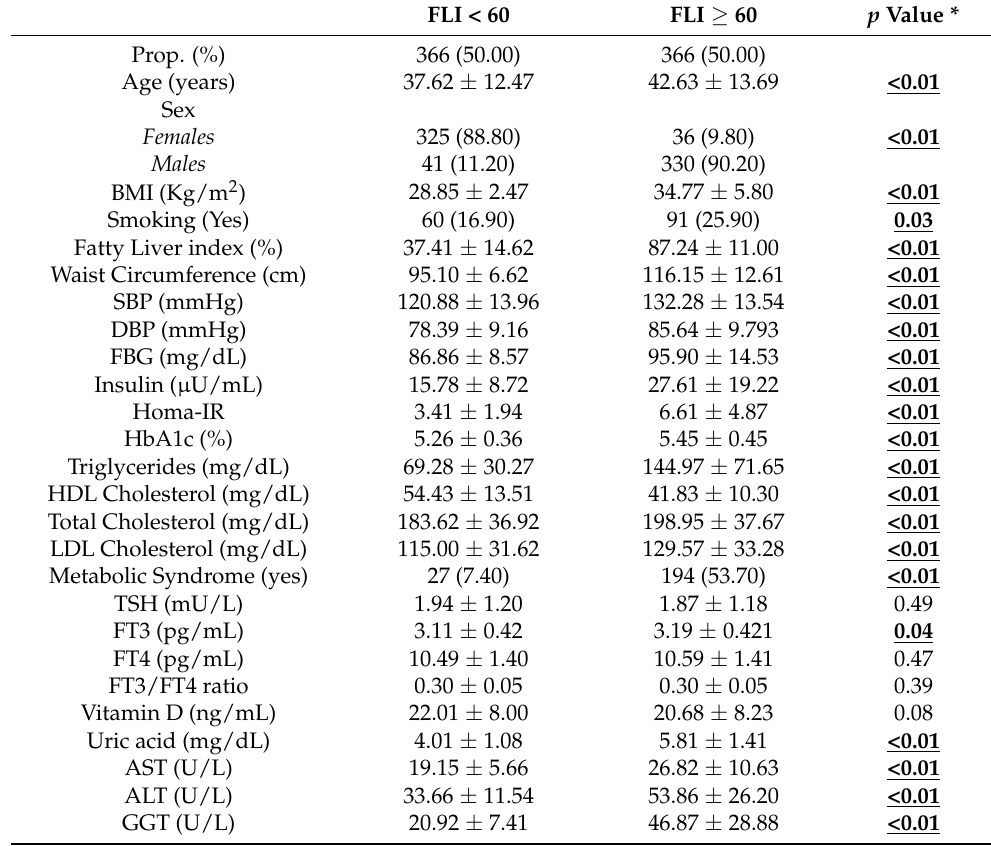
Table 2. Description of the whole sample according to the Fatty Liver Index score after matching for age and sex ( N = 732). All data are shown as mean ± SD (min to max) for continuous variables and as (%) for proportions.